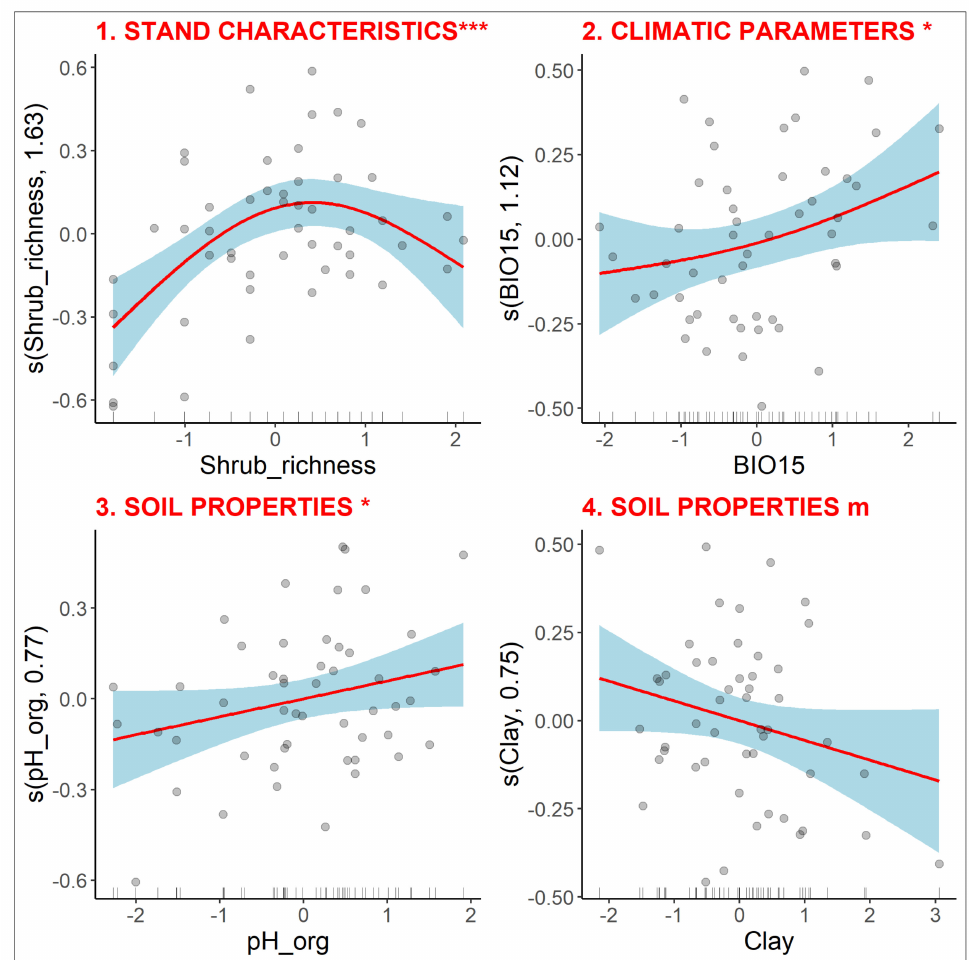
Figure 5. The estimated relationships between the diversity of clonal traits and four explanatory variables included in the final GAM: shrub layer richness, precipitation seasonality (BIO15), pH of the organic soil layer and clay content in the upper mineral soil. The order of predictors reflects their effect size and significance: *** p < 0.001, * p < 0.05, m (marginally significant)— p < 0.1. The confidence interval (95%) is indicated with the light-blue ribbon around each curve. For additional definition of predictors, see Table